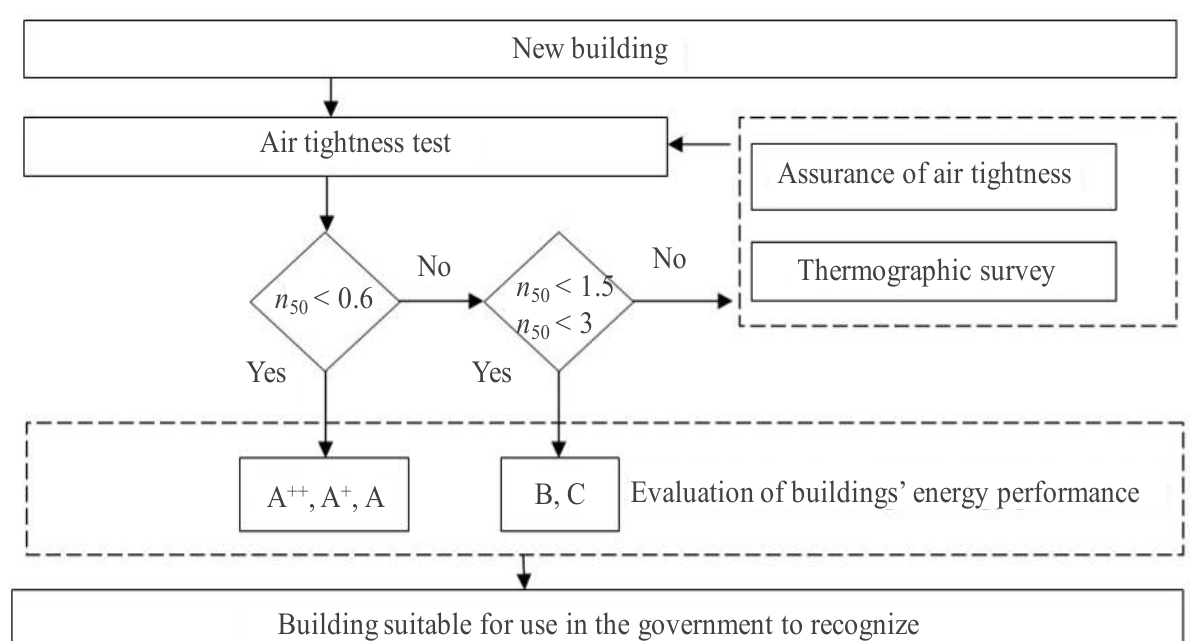
Figure 6. Building energy certification